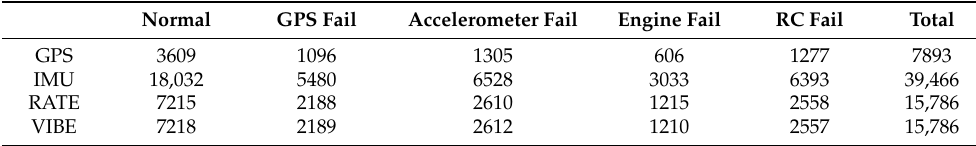
Figure 18. The proportion of each label after processing. Table 8. Data distribution table of the data set after the balancing